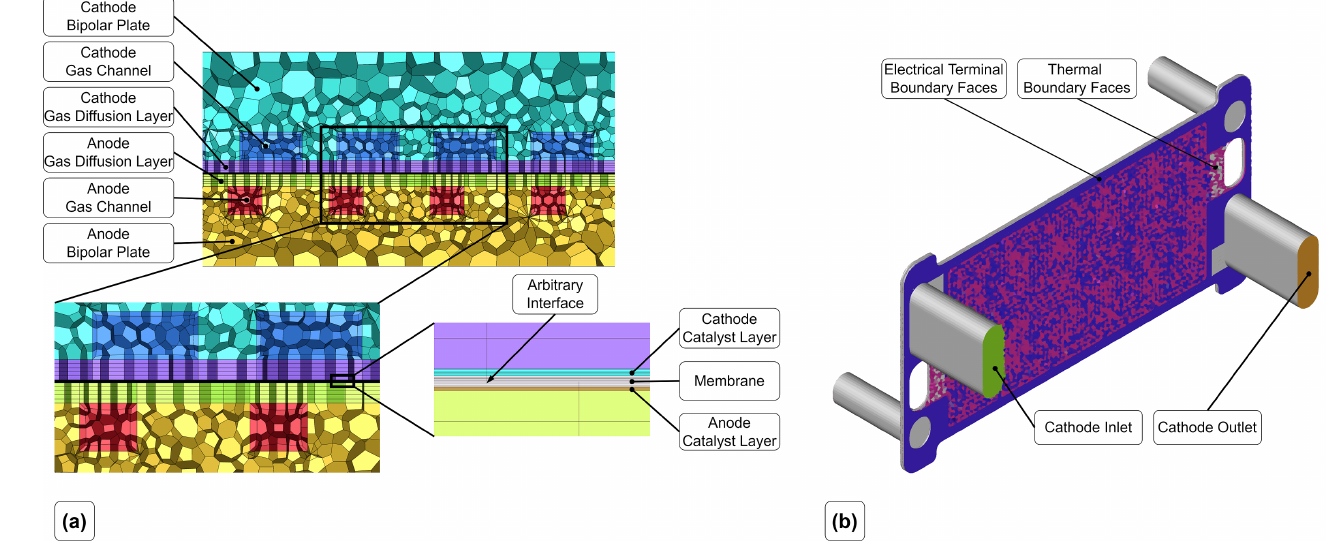
Figure 2. ( a ) Details of the fully resolved channels mesh. Shown is the polyhedral mesh of the bipolar plate and gas channels with one boundary layer. ( b ) Isometric view of the created computational mesh of the fuel cell. Electrical terminal boundary faces, cooling boundary faces, and in/outlet boundary faces of the cathode are shown. Similar boundary faces are present at the anode side. Remaining faces are of type wall. Due to confidentiality reasons, the cooling channels are